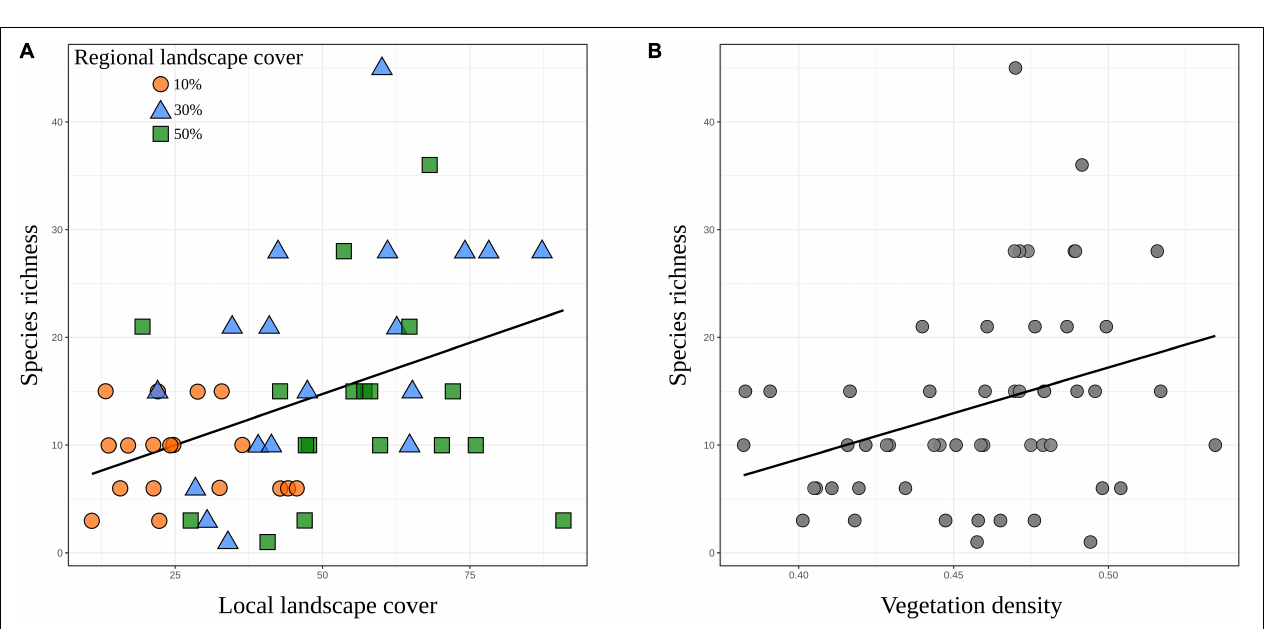
FIGURE 3 | Relationship between extrapolated species richness and (A) local landscape cover or (B) vegetation density in a woodland savanna region of South America. Points in panel (A) are color-coded according to regional landscape cover, which include 10% (orange), 30% (blue), and 50% (green) forest cover.